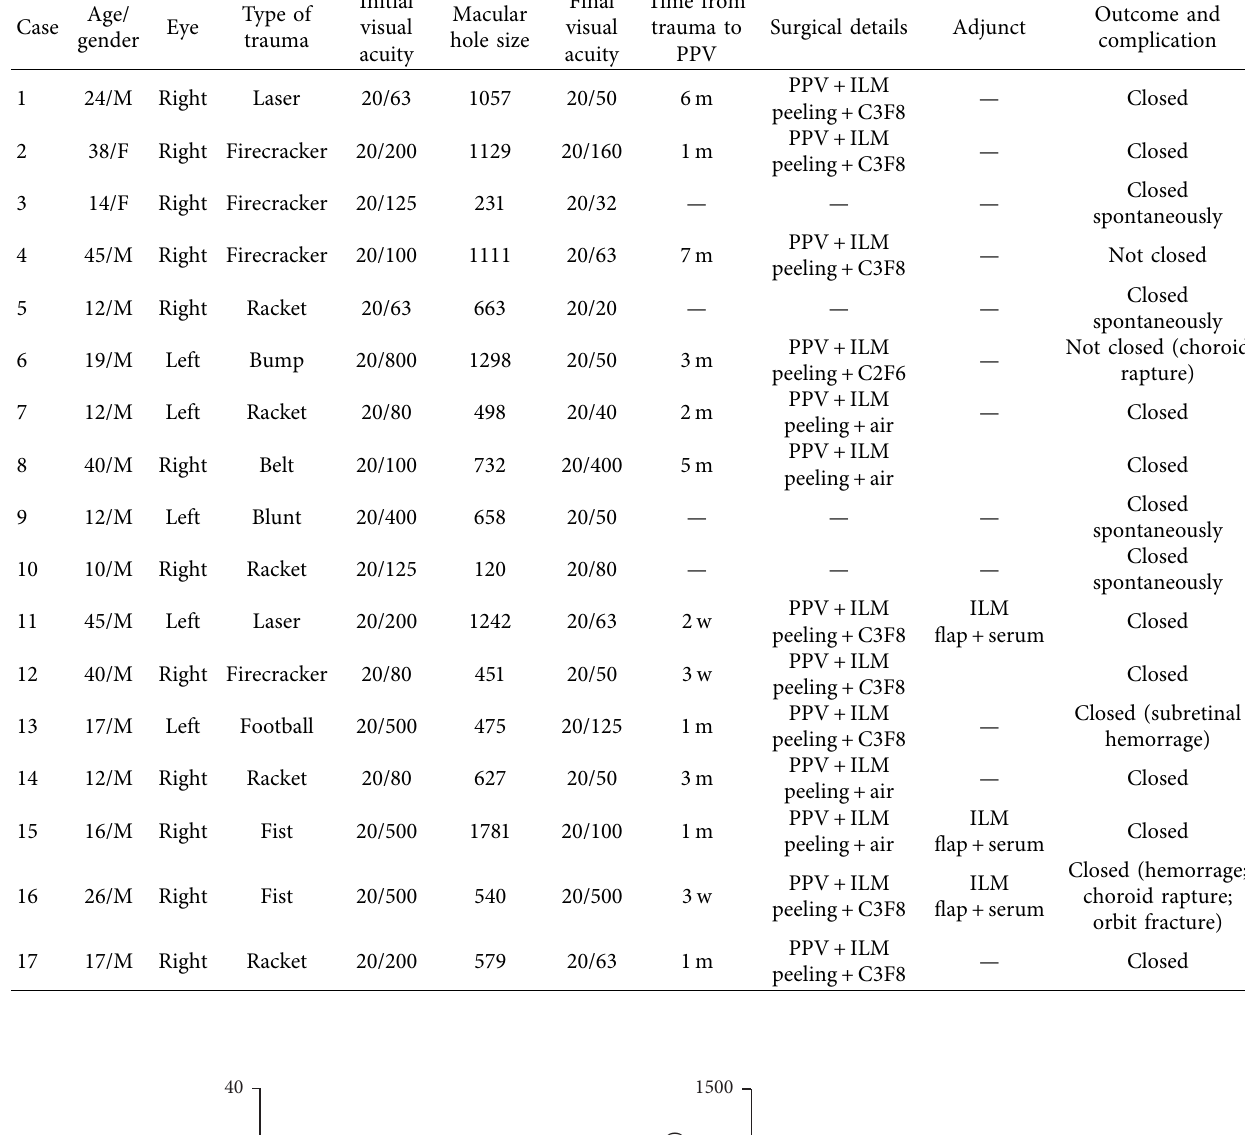
Table 1: All patient’s details, surgery, and